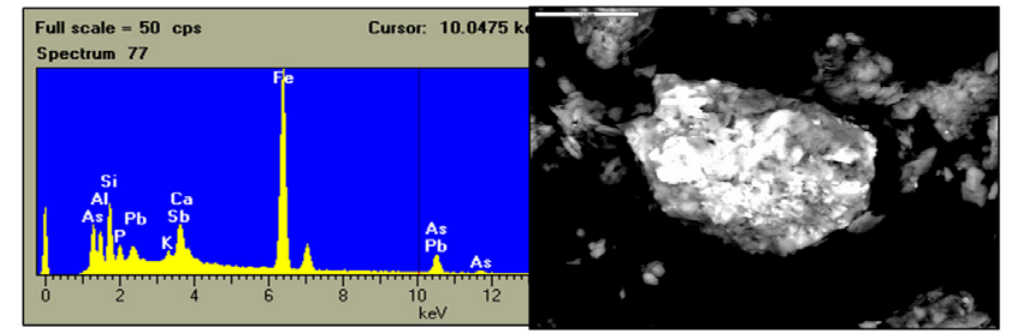
Figure 6. SEM image showing a polycrystalline aggregate composed of iron oxides, micas, quartz and apatite. The spectrum show Pb, Sb and As peaks.